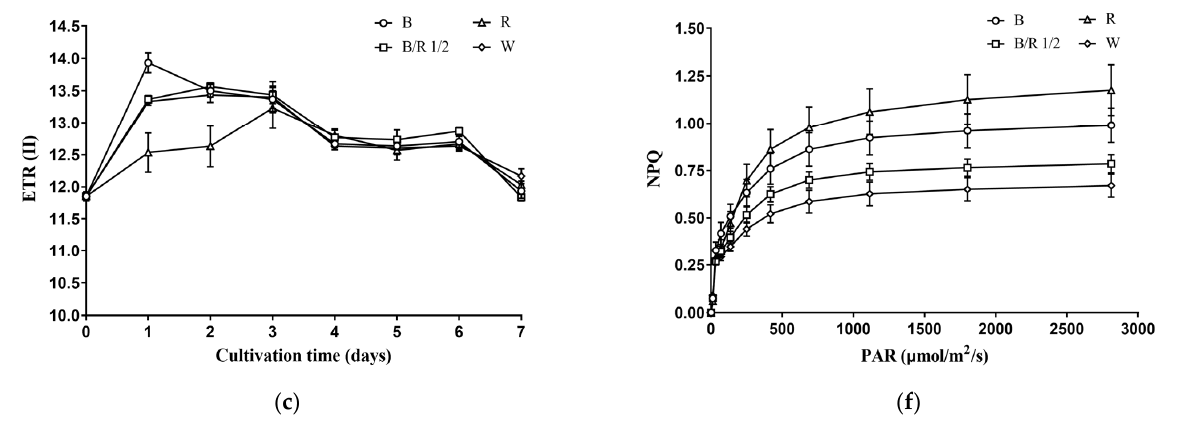
Figure 4. Effect of light spectra on the chlorophyll a fluorescence parameters of H. pluvialis green cells. ( a ) Trend of Fv/Fm with time. ( b ) Trend of Y(II) with time. ( c ) Trend of ETR(II) with time. ( d ) Trend of Y(II) with light intensity. ( e ) Trend of ETR(II) with light intensity. ( f ) Trend of NPQ with light intensity. In ( a – f ), B—Blue light; B/R 1/2—blue/red light 1/2; R—red light; W—white light. Results were presented as mean ± SD of the measurements of three biological replicates.